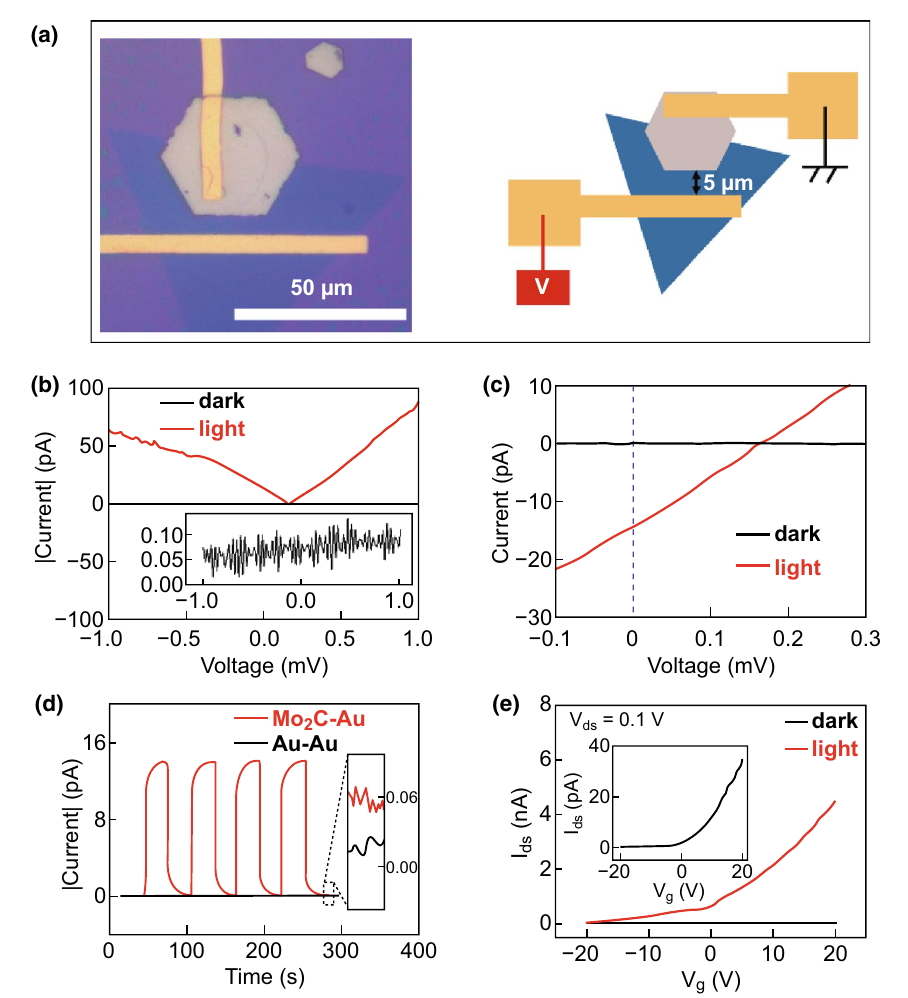
Fig. 5 a Optical image and schematic illustration of the Mo 2 C/MoS 2 /Au device. b | I |– V curves of Mo 2 C/MoS 2 /Au devices with (red) and with- out (black) 80 mW cm −2 white light irradiation. The inset image shows the magnified dark current. c Magnified I - V curves of Mo 2 C/MoS 2 /Au devices with a bias voltage range of − 0.1 to 0.3 mV. d Photocurrent response of self-powered Mo 2 C/MoS 2 /Au (red) and Au/MoS 2 /Au (black) devices under 80 mW cm −2 white light irradiation. The image in the inset shows the magnified dark current. e Transfer characteristic curves of the photodetector with and without white light